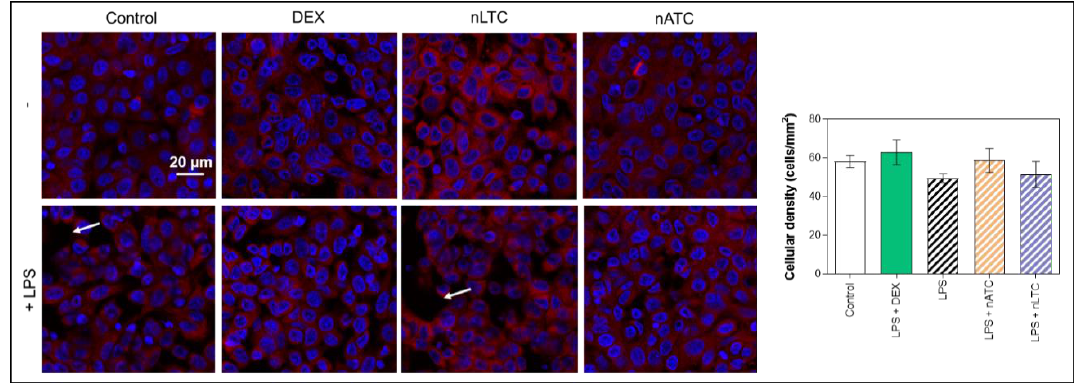
Figure 12. Cellular density after CUR nanovesicles were nebulized on the liquid-air interface of an A549 cells monolayer as an in vitro model of pulmonary alveoli. White arrows point out regions of the monolayers without cells.